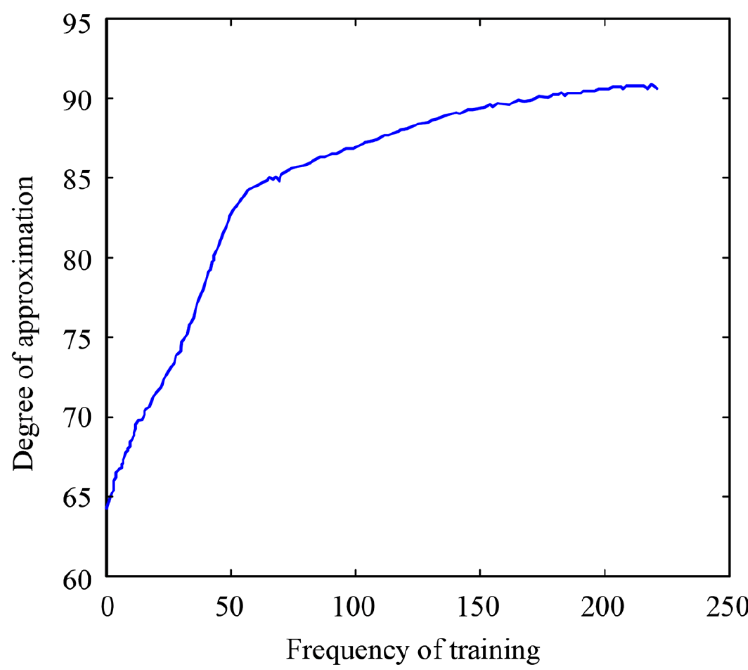
Figure 7. Approximation curve after inverse transformation.